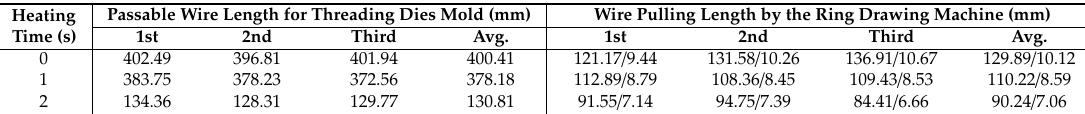
Table 18. Results based on wire pulling speed: k7(12.83 mm / s).